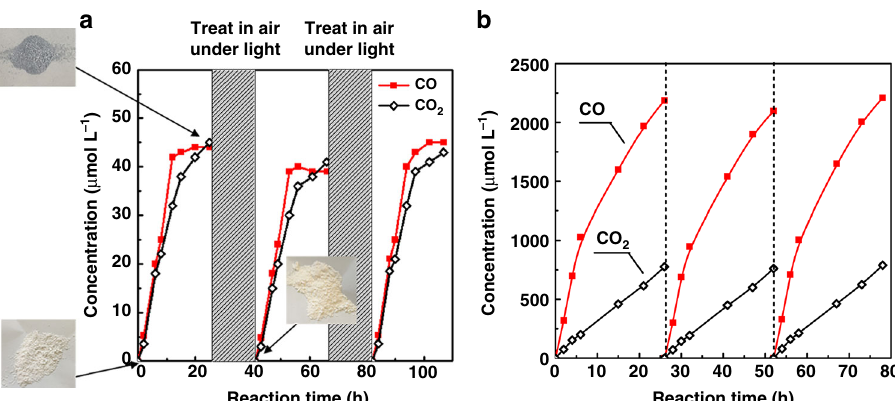
Fig. 5 Carbon monoxide and carbon dioxide concentrations in the reactor. a After exposure of Zn-HPW/TiO 2 to pure methane (CH 4 0.3 MPa). The catalyst was regenerated by treatment in 1 bar of air under light at ambient temperature. b After exposure of Zn-HPW/TiO 2 to CH 4 and air. Reaction conditions: catalyst, 0.1 g; gas phase pressure, CH 4 0.3 MPa, Air 0.1